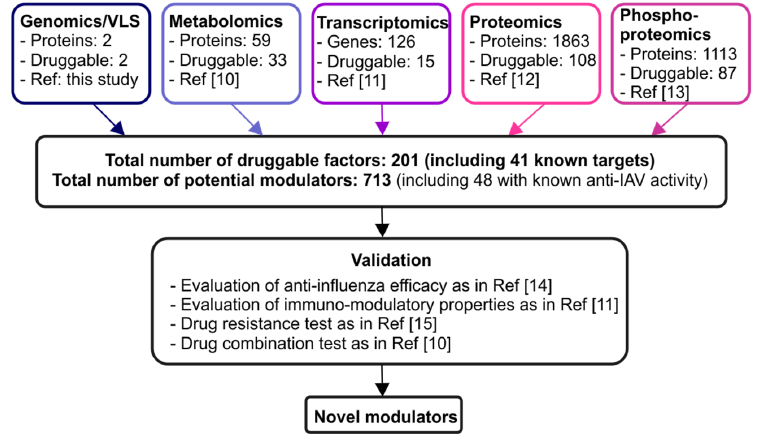
Figure 1. Discovery pipeline for novel modulators of IAV–host interactions. Altogether 713 potential modulators of virus ‐ host interactions derived from the analysis of our recent omics studies [10–13].